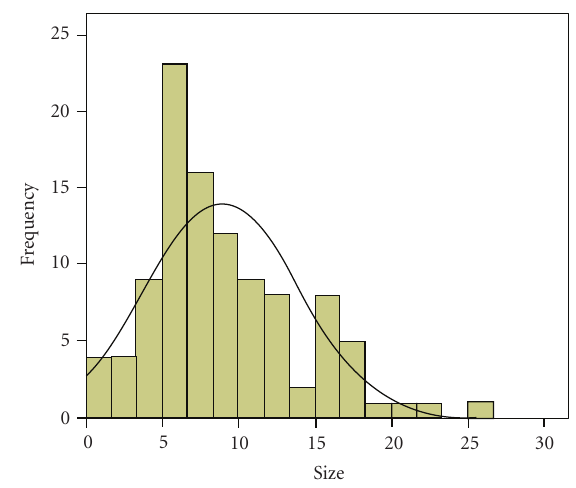
Figure 1: Size of tumour at presentation to ROH.